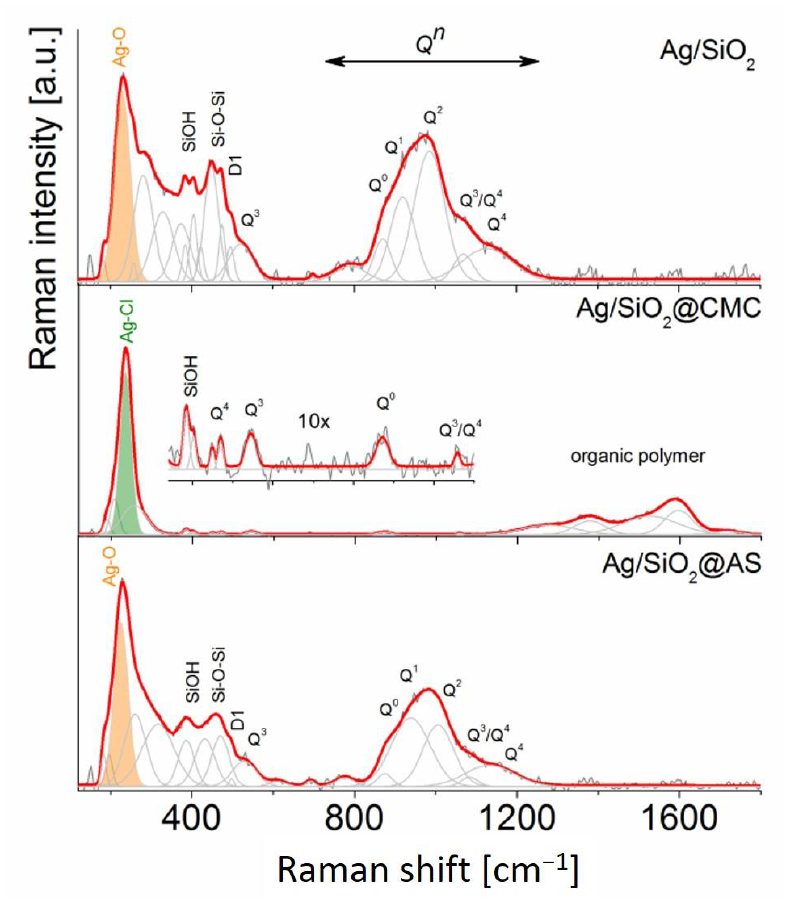
Figure 3. The Raman spectra of the silver-silica (Ag / SiO 2 ) and modified nanocomposites through carboxymethylcellulose (Ag / SiO 2 @CMC) and sodium alginate (Ag / SiO 2 @AS) were in the 120–1800 cm − 1 region. Additionally, to better illustrate the silica matrix signal, the 350–1100 cm − 1 region in Ag / SiO 2 @CMC was magnified 10 × . Each spectrum was fitted using the Voigt function and a minimum number of components.